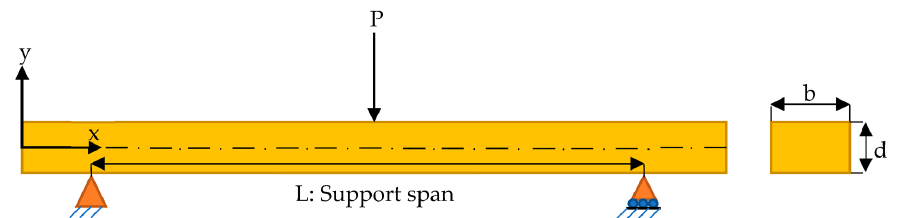
Figure 4. Simply supported beam with a concentrated load from the centre of the support span .